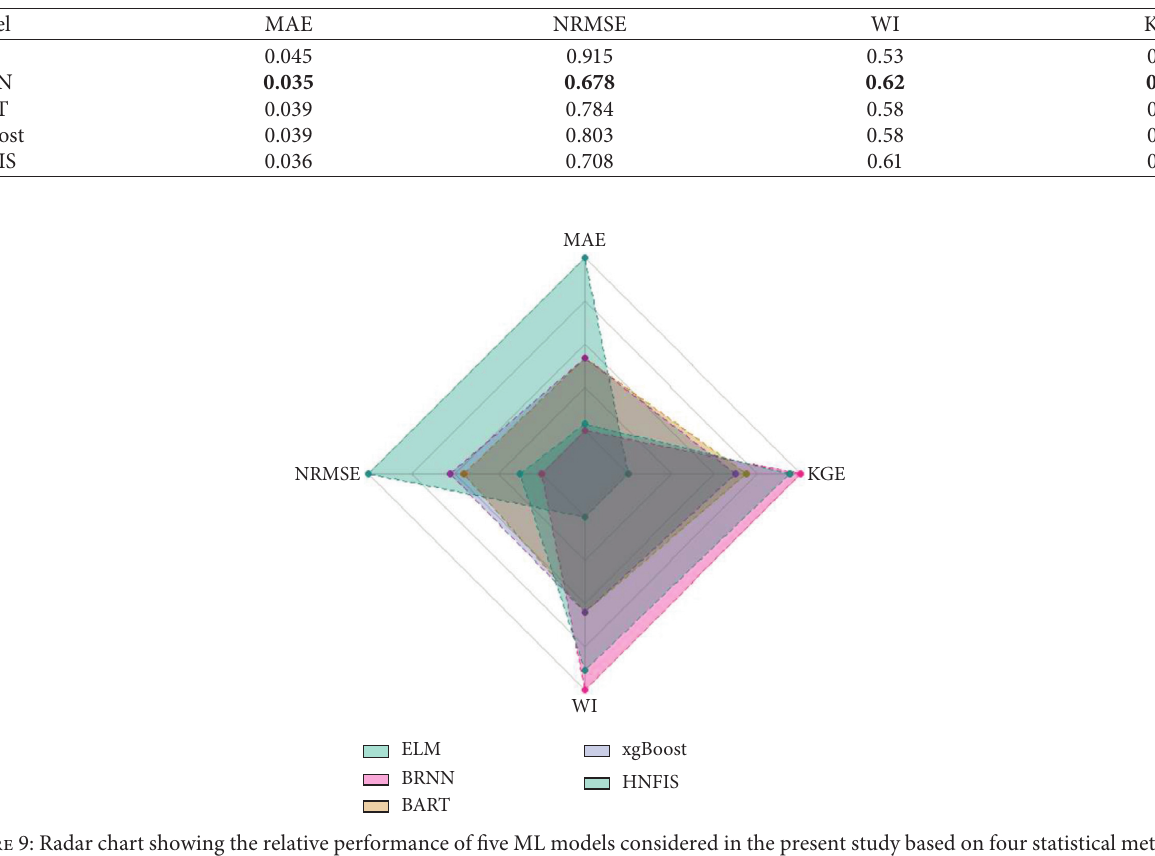
Table 1: Performance of the ML models in terms of two error and two association-based statistical metrics. The bold number indicates the best performance.